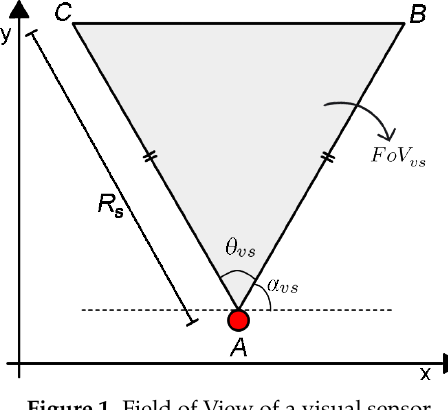
Figure 1. Field of View of a visual